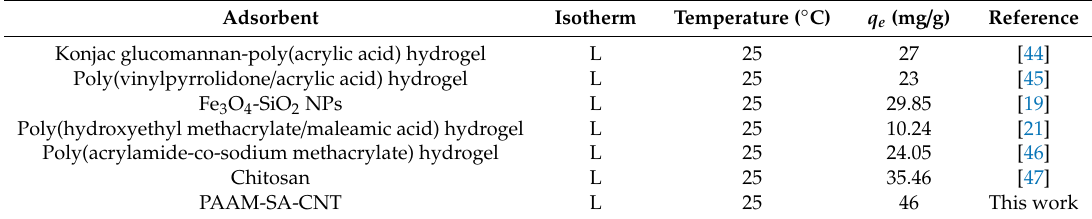
Table 2. Cu 2 + adsorption capacities for various